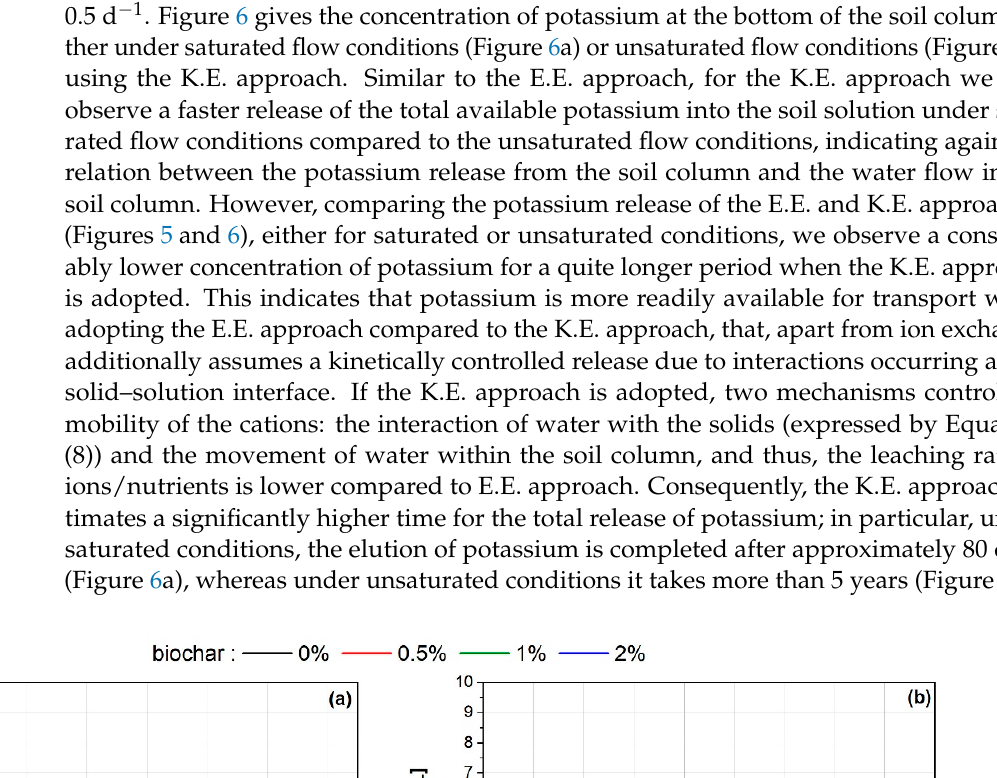
Figure 7. Effect of different values of the rate constant (k) in potassium release under ( a ) saturated and ( b ) unsaturated conditions.